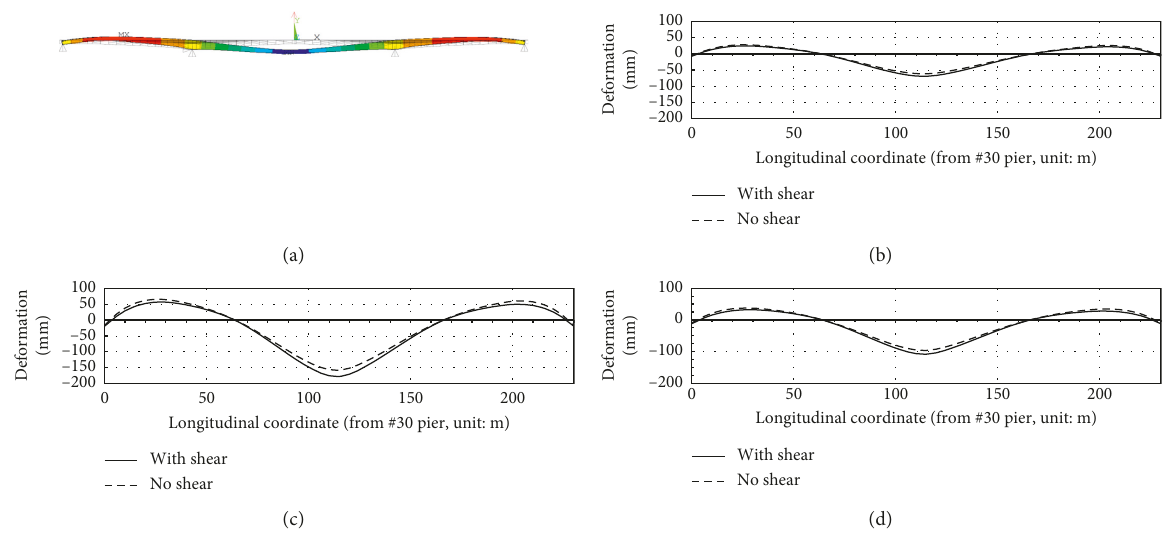
Figure 4: Long-term deformation of the prototype bridge. (b) Age: 0 days. (c) Age: 3650 days, absolute value. (d) Age: 3650 days, relative value c −